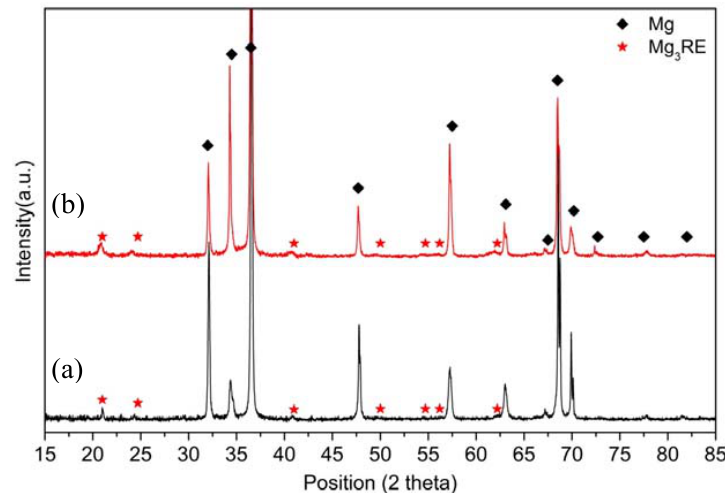
Figure 8. XRD spectra of EL21: ( a ) after solutionizing at 580 °C; and ( b ) solutionizing at 580 °C followed by ageing at 200 °C for 96 h.